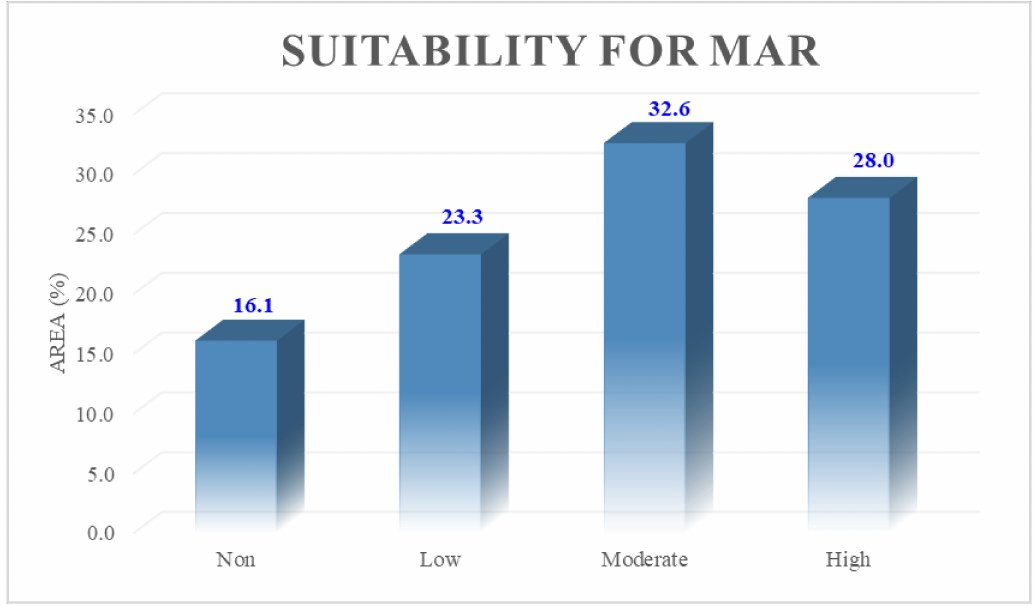
Figure 5. Distribution of MAR suitable areas in study